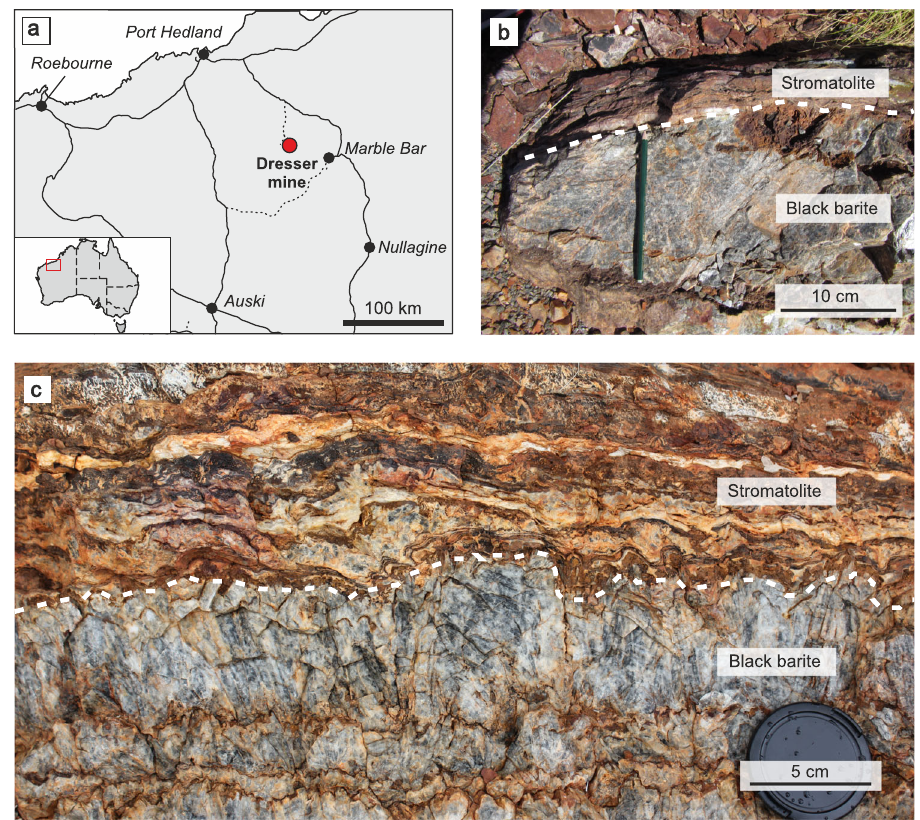
Fig. 1 Study area and fi eld evidence. Location of the Dresser mine in Western Australia near Marble Bar ( a ) and black barite associated with originally sul fi dic stromatolites at the sampling site ( b ) and in the working area ( c ). The close association between the inclusion-bearing black barites and stromatolites suggests that hydrothermal fl uids might have in fl uenced ancient microbial